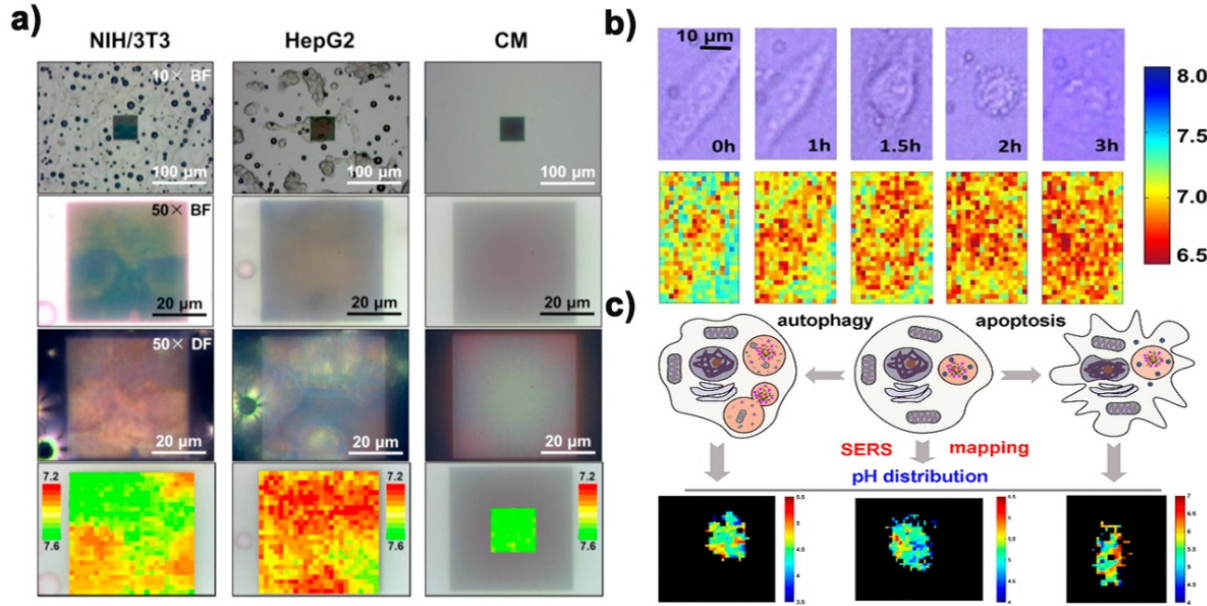
Figure 6. ( a ) Optical images and pHe SERS map of NIH/3T3 and HepG2 cells after culture on 4-MBA modified Q3D-PNA SERS substrates. Reprinted with permission from ref. [33]. Copyright 2015 Elsevier B.V. ( b ) Bright field microscope image (upper panel) and real-time in situ pHe images of SCC-4 cell (lower panel). Reprinted with permission from ref. [34]. Copyright 2018 American Chemical Society. ( c ) In situ SERS imaging and schematic of pHi during autophagy and apoptosis of lysosomes. Reprinted with permission from ref. [75]. Copyright 2019 American Chemical Society.